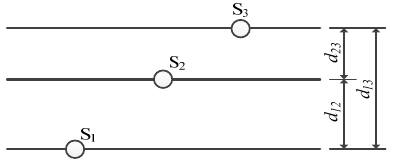
Figure 11. Closure property for a plane wave.